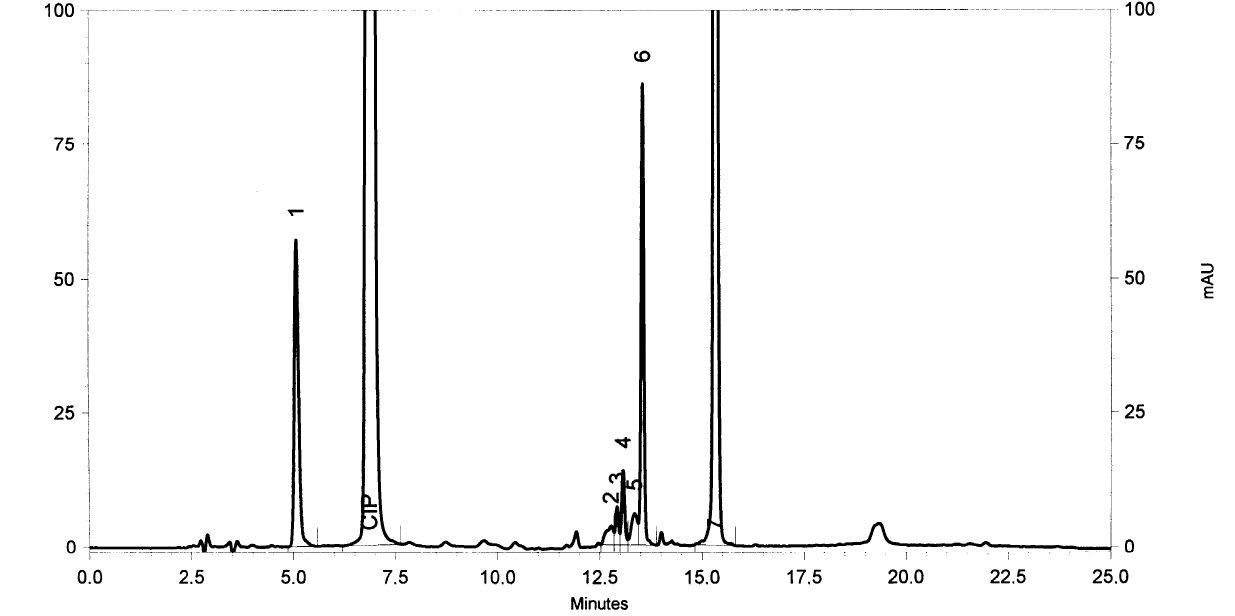
Figure 3. Chromatogram of the CIP oxidized by ACVA after incubation for 336 h at 40 °C.